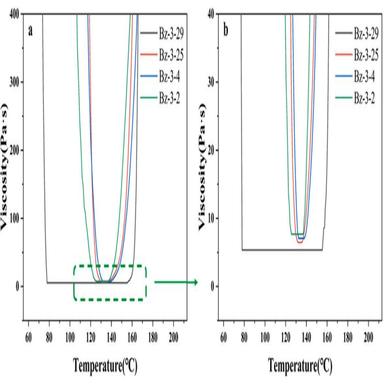
Viscosity− temperature curves of the benzoxazines. The vertical coordinate scale ranges are (a) 0–400 and (b) 0 to 40.